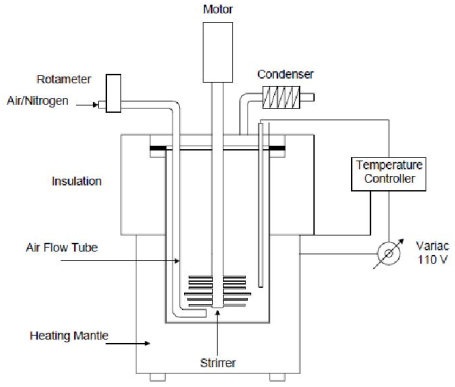
Figure 2. The air-blowing device for oxidation aging of bitumen.